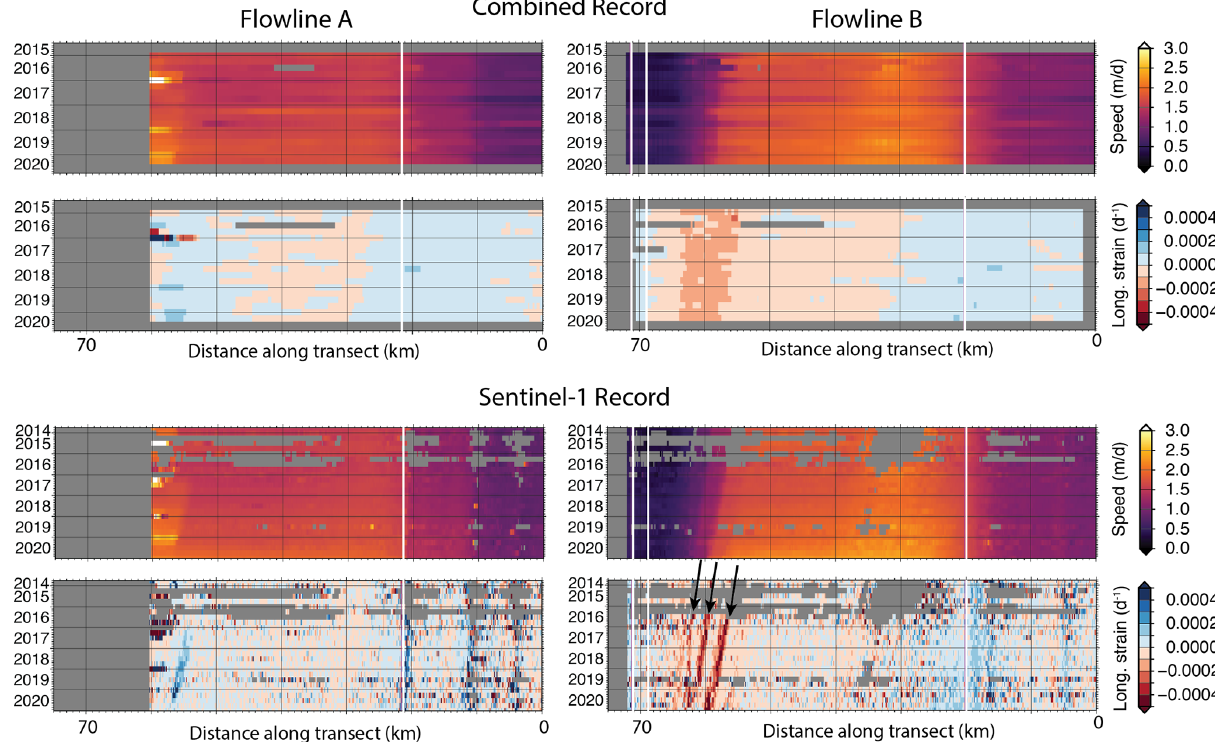
Figure 6. Hovmöller diagrams of speed and longitudinal strain rates from our 5-year combined record and from Sentinel-1 radar speckle tracking for Flowlines A and B (Fig.